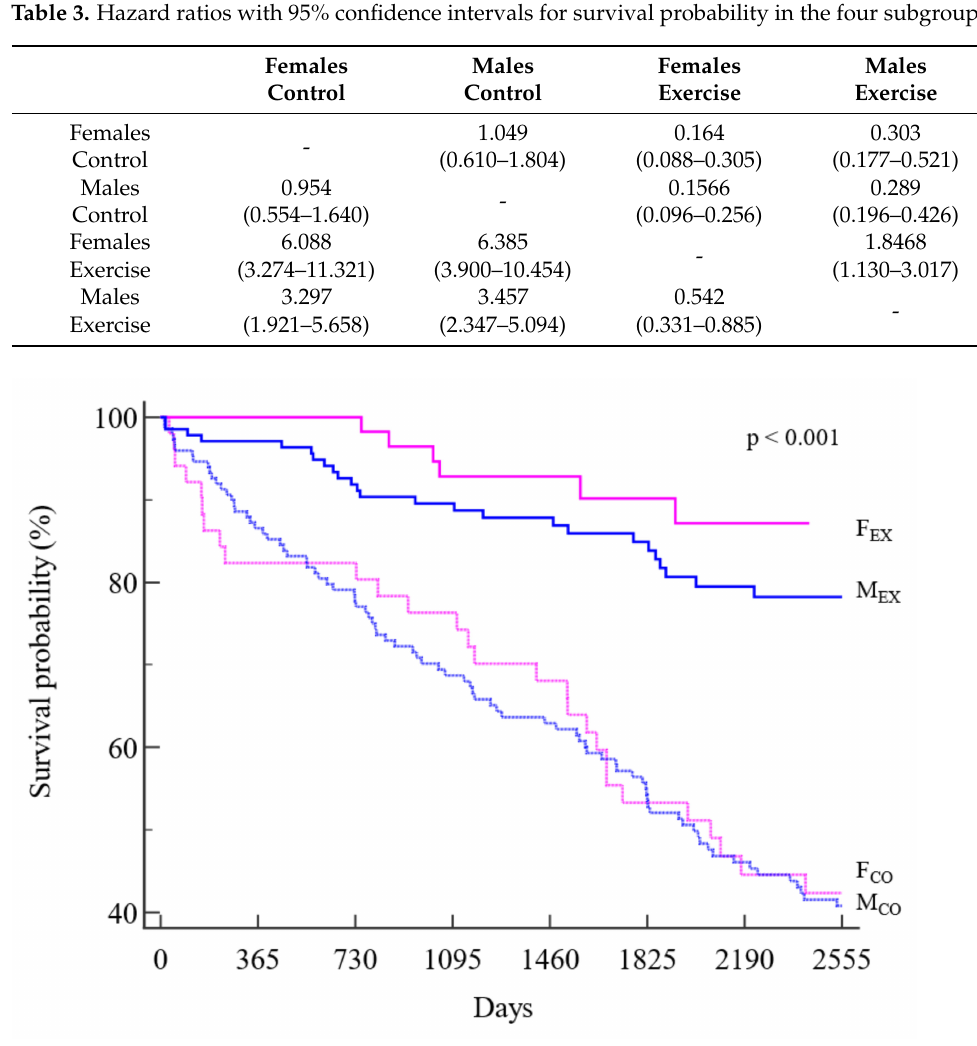
Table 3. Hazard ratios with 95% confidence intervals for survival probability in the four subgroups.